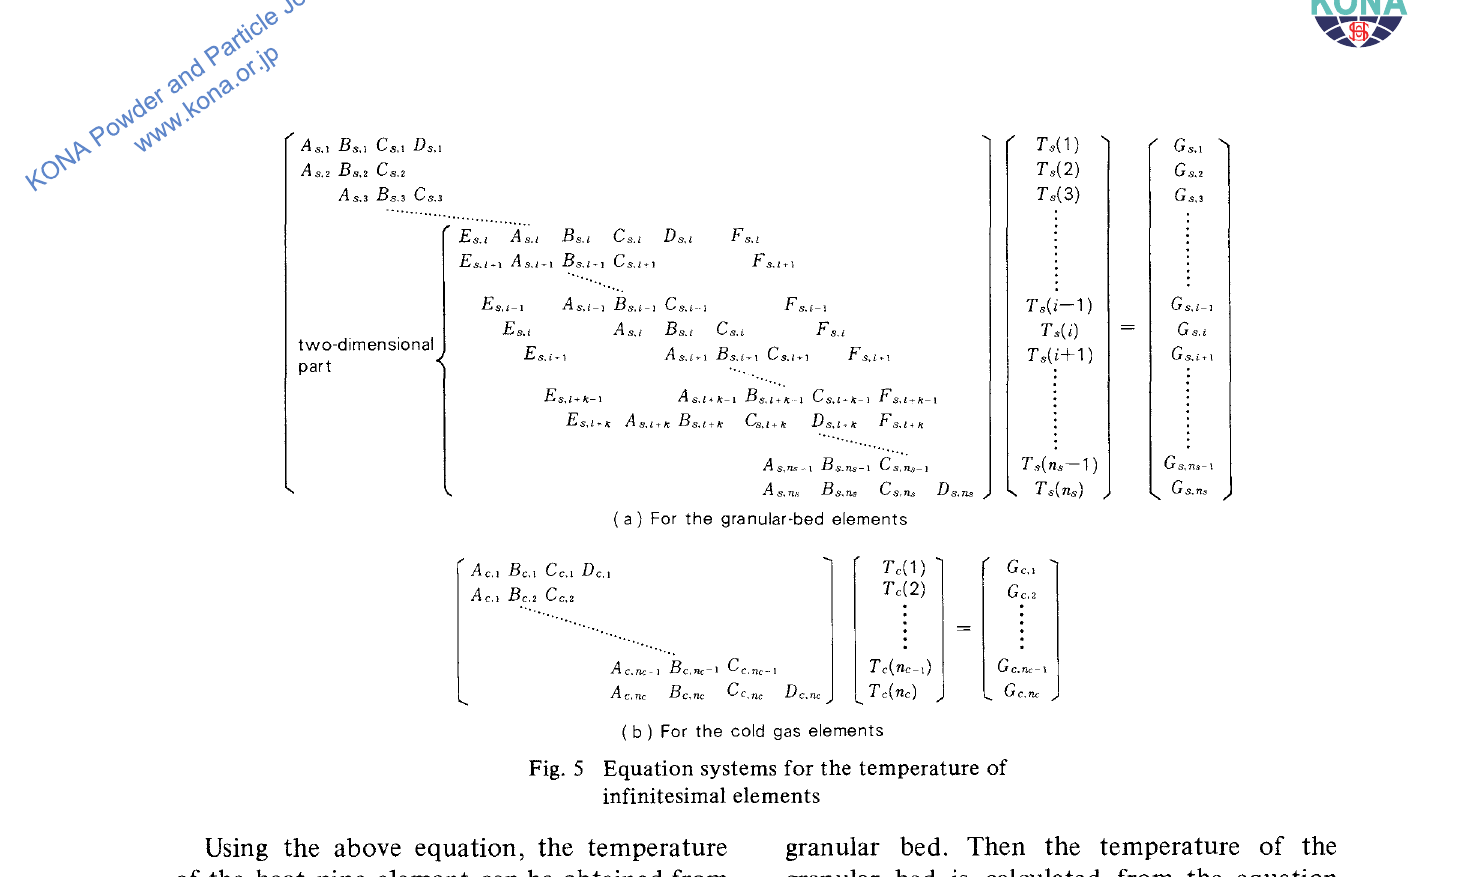
Fig. 5 Equation systems for the temperature of infinitesimal